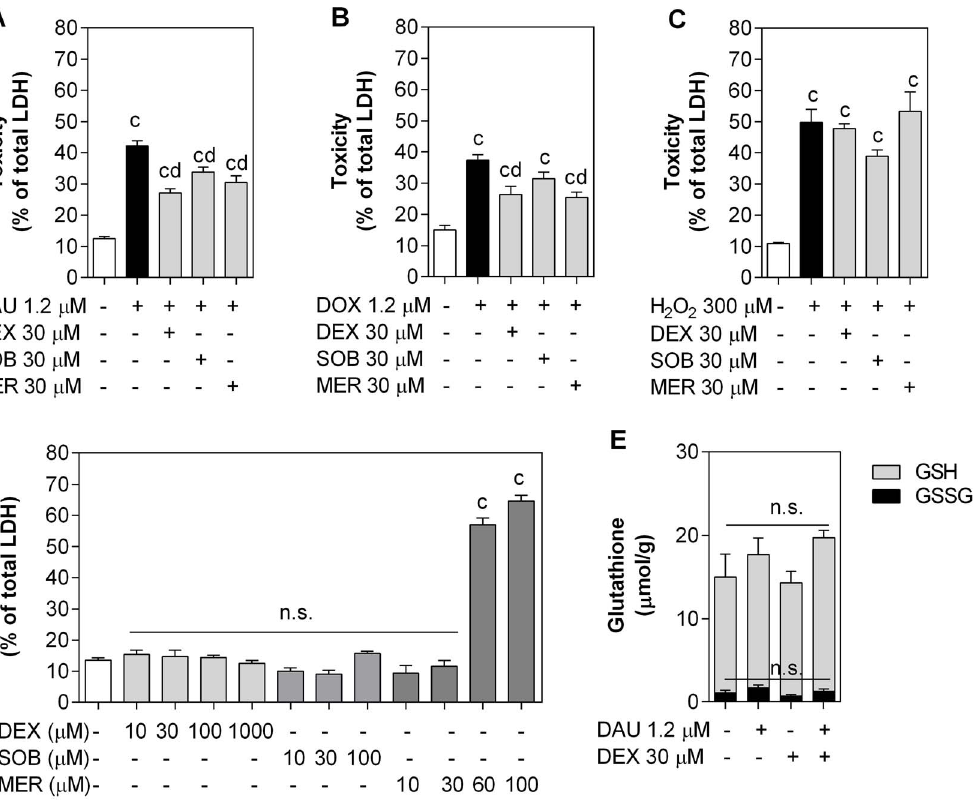
Figure 3. Effects of the studied substances on the viability and glutathione levels in neonatal rat cardiomyocytes. Neonatal rat cardiomyocytes were pre-incubated with dexrazoxane (DEX), sobuzoxane (SOB) or merbarone (MER) for 3 h and then incubated with anthracyclines daunorubicin (DAU, A) or doxorubicin (DOX, B) for 3 h following a 48-h anthracycline-free period or for 48 h with hydrogen peroxide (H 2 O 2 , C). DEX, SOB and MER individual toxicity after 48-h incubation is shown in panel D. Effects of DEX pre-treatment for 3 h with a 3-h DAU incubation and subsequent 48-h DAU-free period on cellular oxidised and reduced glutathione content are shown in panel E. Data obtained from $ 4 independent experiments are expressed as the mean 6 SD, statistical significance: c – compared to control; d – compared to DAU or DOX (one-way ANOVA with Dunnett’s post-test, P # 0.05).